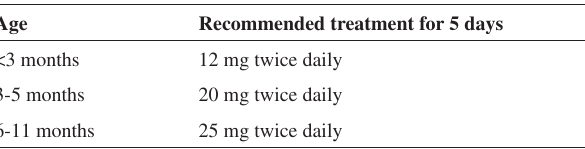
Table 2 - Recommended antiviral treatment for children